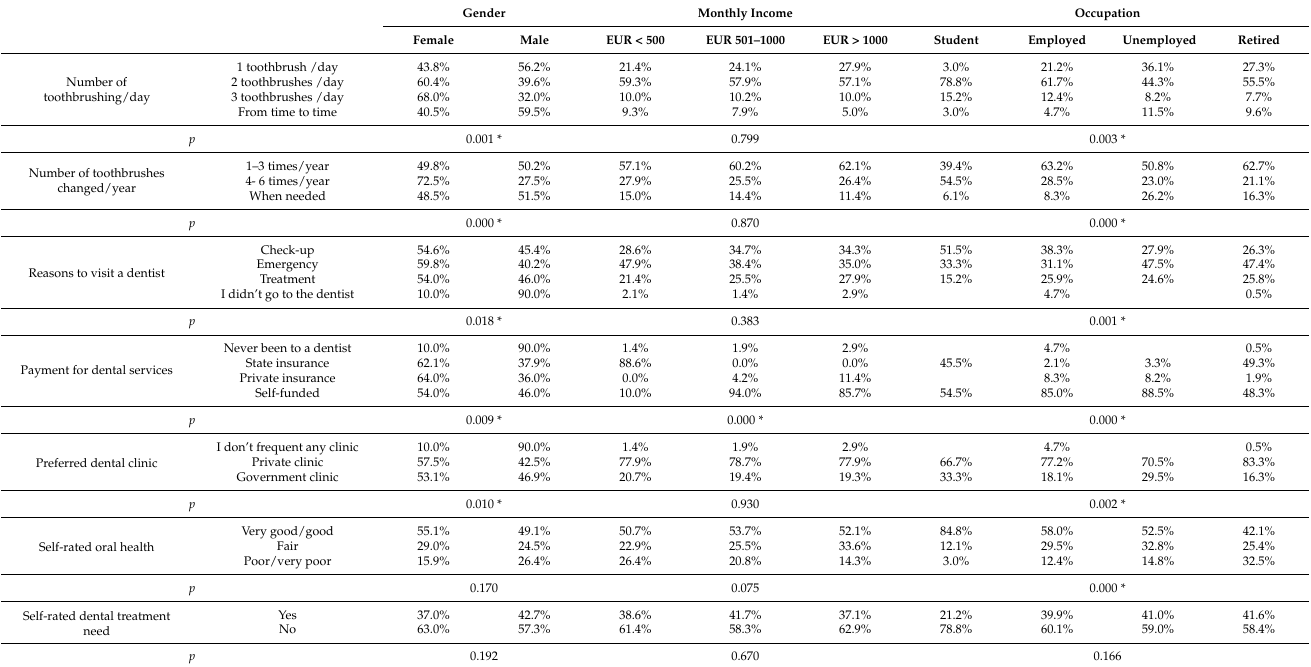
Table 3. Relationship between the gender and monthly income variables with factors that can influence access to dental